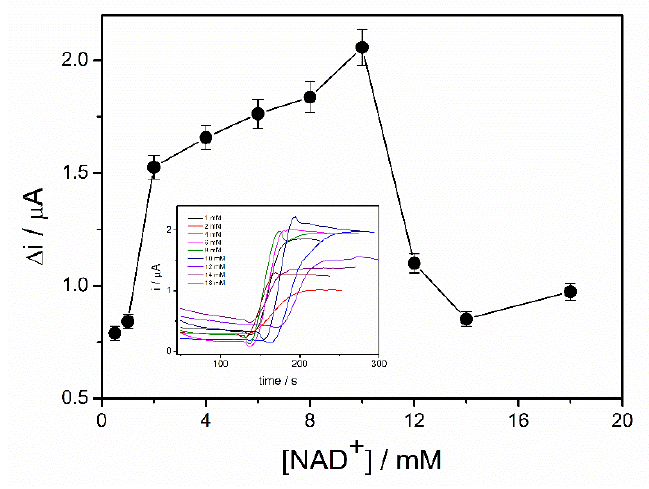
Figure 4. Influence of NAD + concentration on the biosensor response (E = +500 mV, PBS 0.1 M pH = 8.8, 4 mM ethanol, n = 3) (inset: chronoamperometric response curves recorded for NAD + concentrations range 0.5–18 mM).